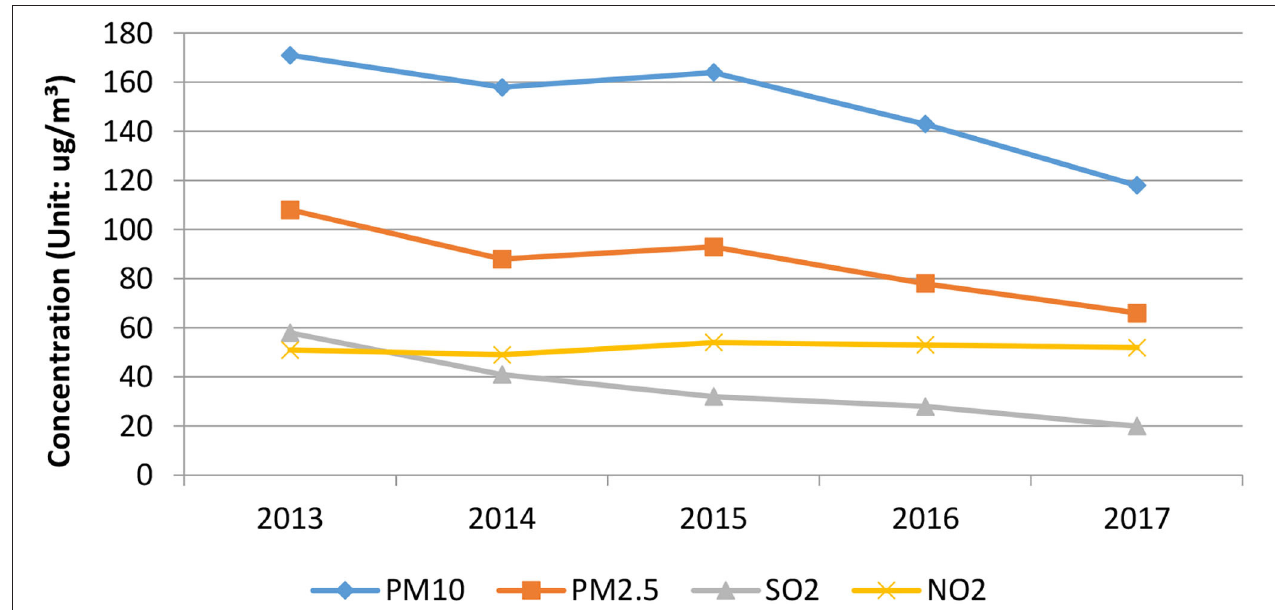
FIGURE 3 | Interannual variations trends of the concentration of inhalable particulate matter in Z City from 2103 to 2017.